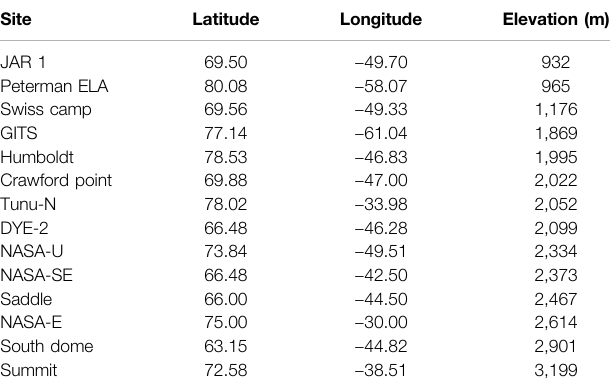
TABLE 2 | AWS site locations used in the microwave product